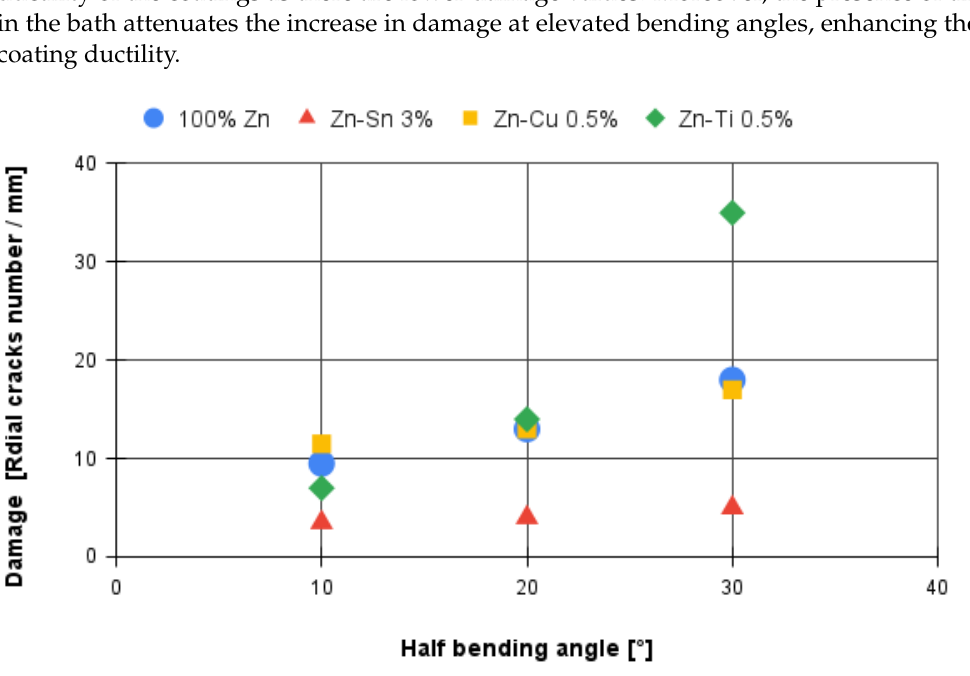
Figure 12. Damage of coatings produced with 180s of dipping time.